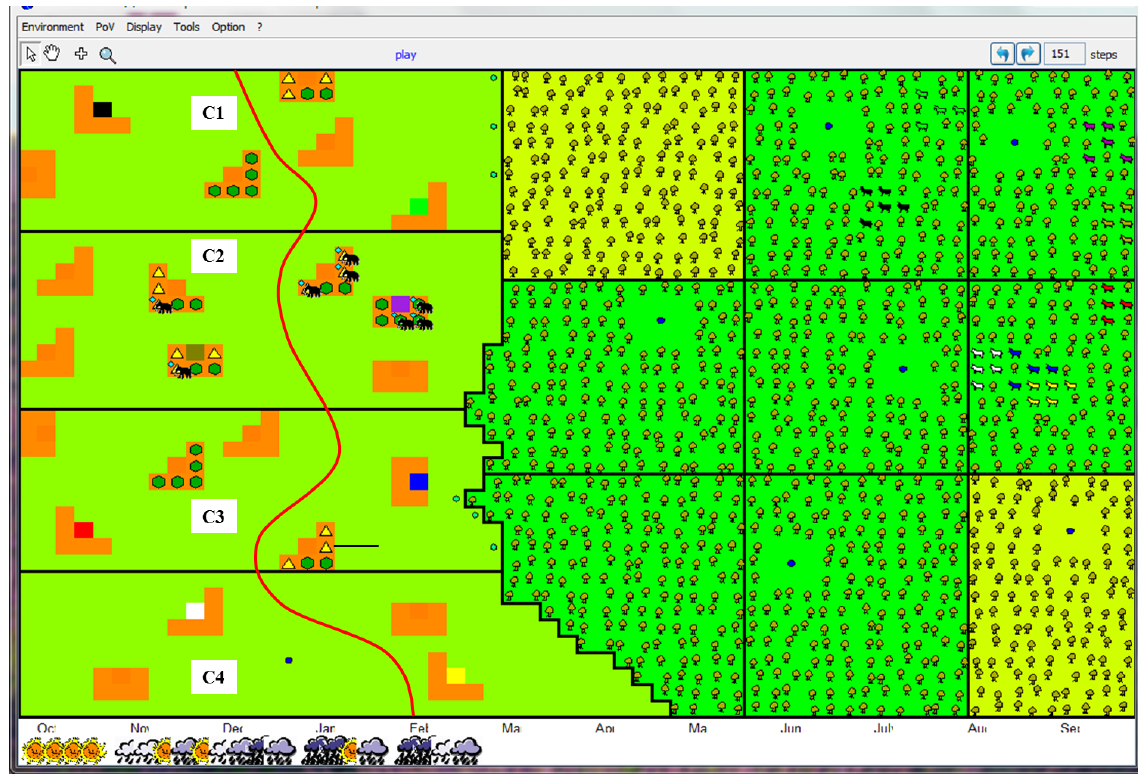
Figure 9. Elephants’ damages . Grazing areas with mature maize (here C1, C2 and C3) are prone to crop raiding by elephants. C2, which was not guarded (no small green circles at the edge between the communal land and the forest) was attacked by elephants. Farms located on the right side of the red line are considered as the first line of farms. These farms are more heavily impacted by the